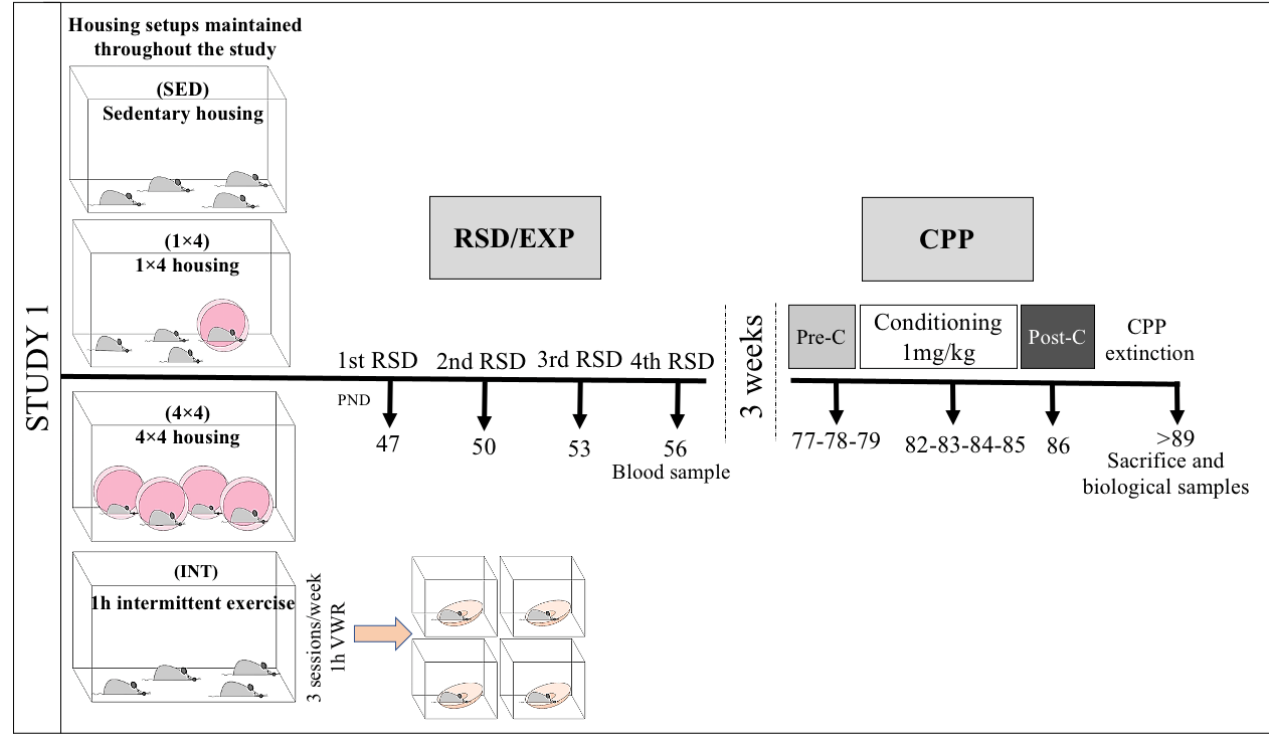
Figure 1. Experimental design and experimental groups of Study 1.